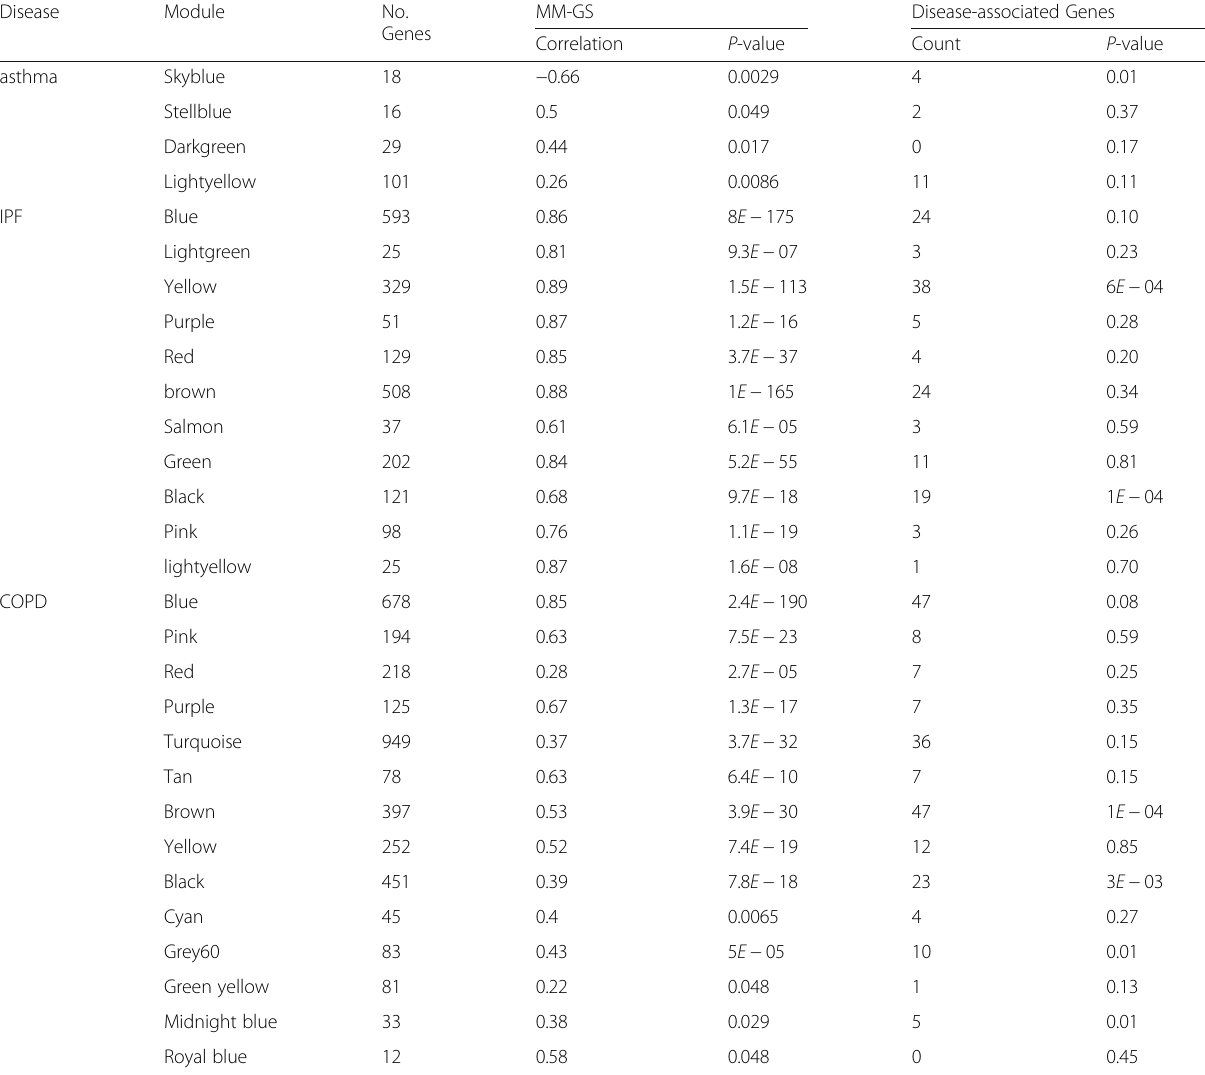
Table 3 The Final Result of MM-GS and Disease-associated Genes Analyses for Identifying the Most Important Modules in COPD, IPF, and Asthma after Second and Third Filters